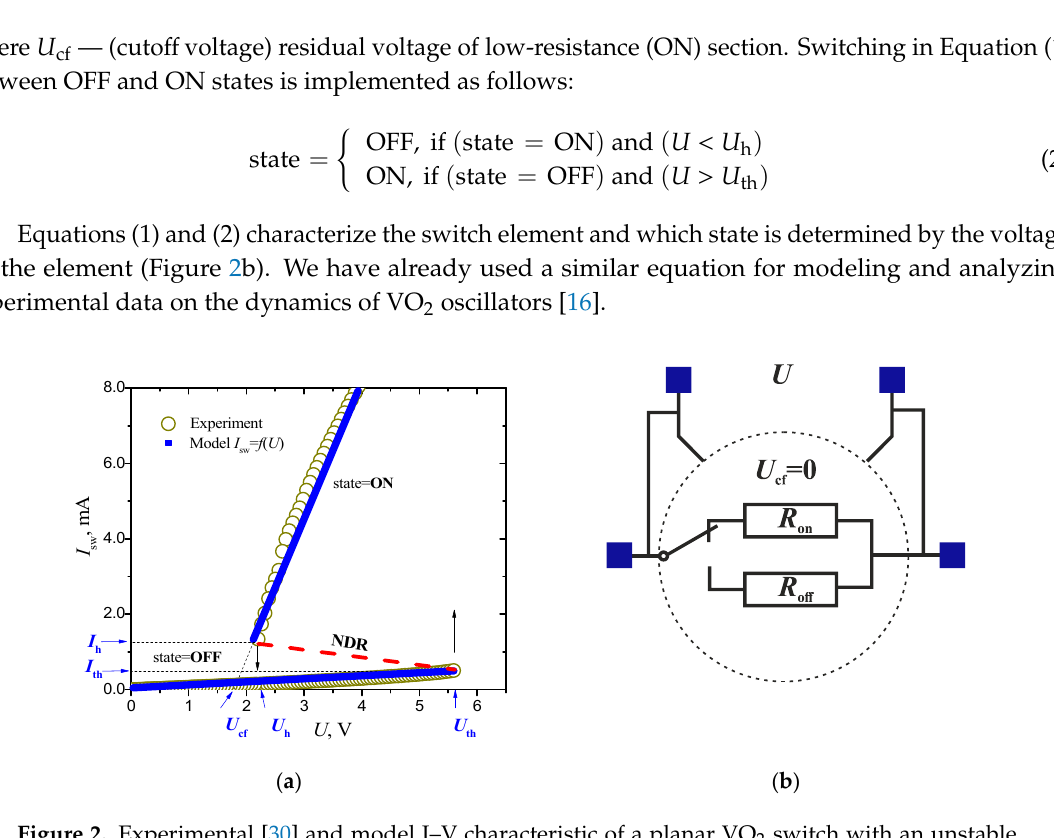
Figure 2. Experimental [30] and model I–V characteristic of a planar VO 2 switch with an unstable NDR ( a ) and an electrical key diagram for a model I–V characteristic with U cf = 0 ( b ). The VO 2 switch parameters for I sw ( U ) (1-2) are: U th = 5.64 V, U h = 2.12 V, U cf = 1.754 V, R off = 10742 Ω and R on = 276 Ω .